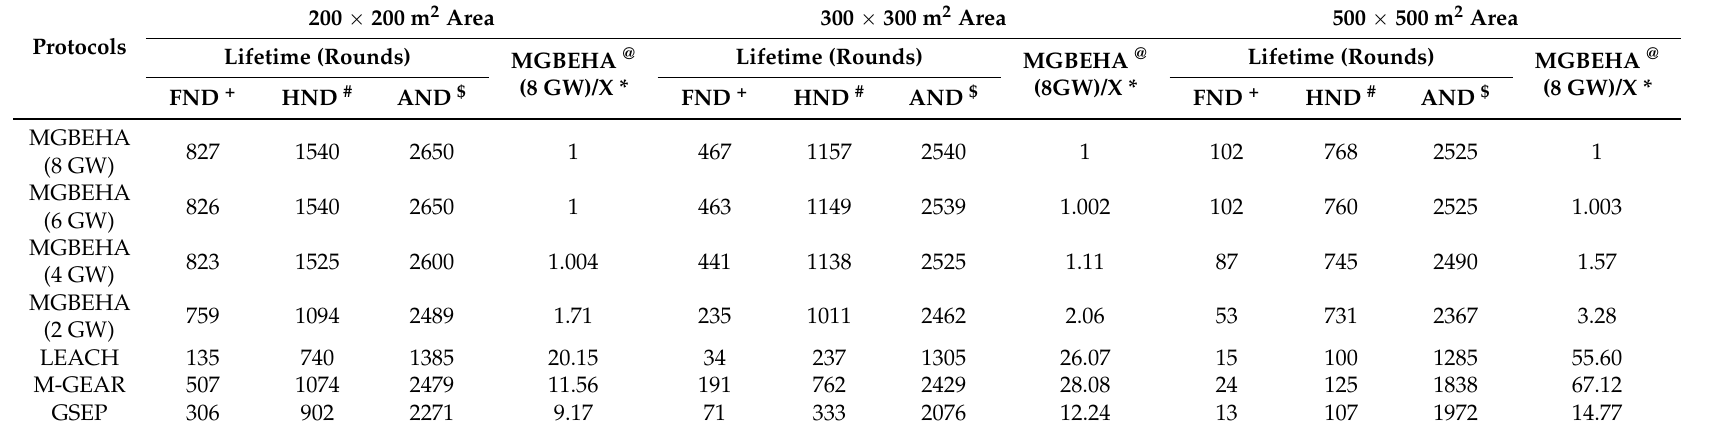
Table 5. Protocol performance of 100 nodes for different area